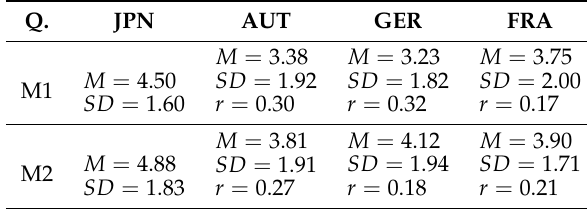
Table 3. Effect size of Tukey HSD with